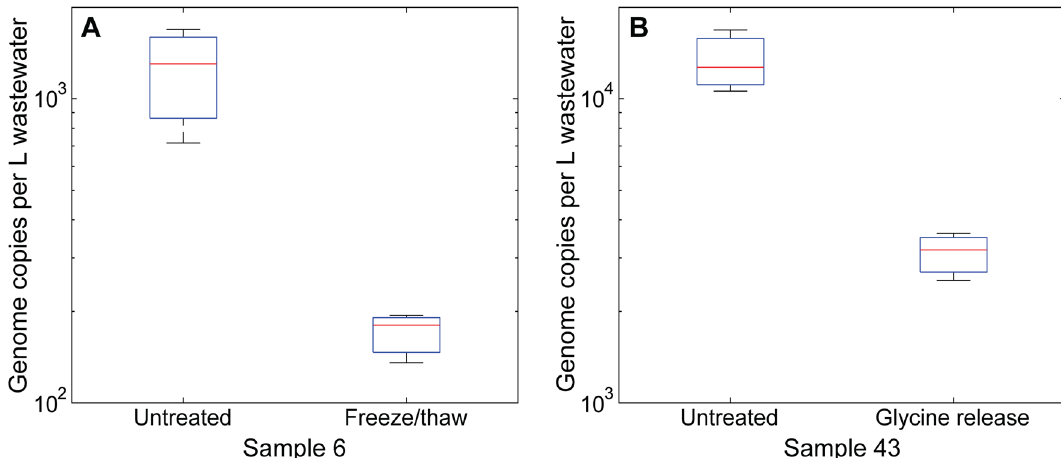
Figure 2. Effect of bulk sample processing on virion isolation from matched wastewater samples. Data were generated by RT-qPCR in technical triplicate. Box plots display minimum, maximum, interquartile range, and